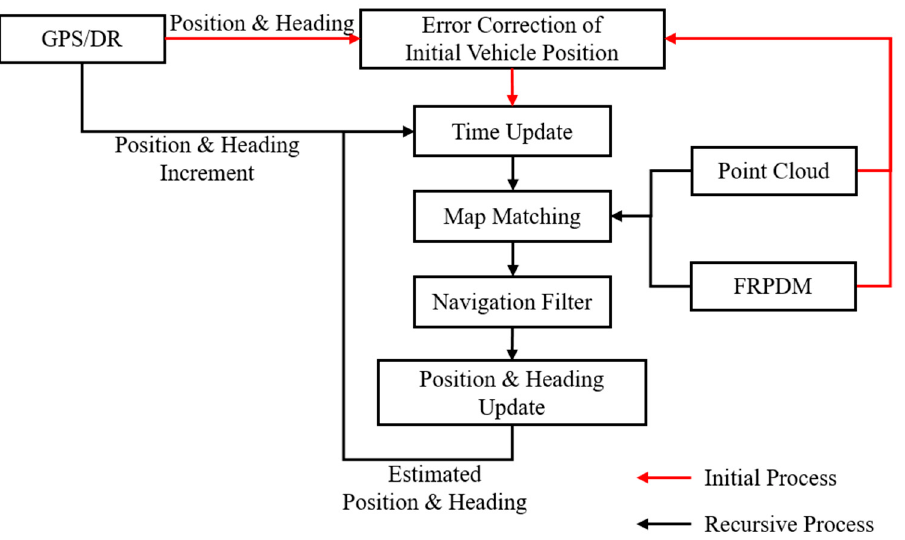
Figure 2. Process of Vehicle Localization.